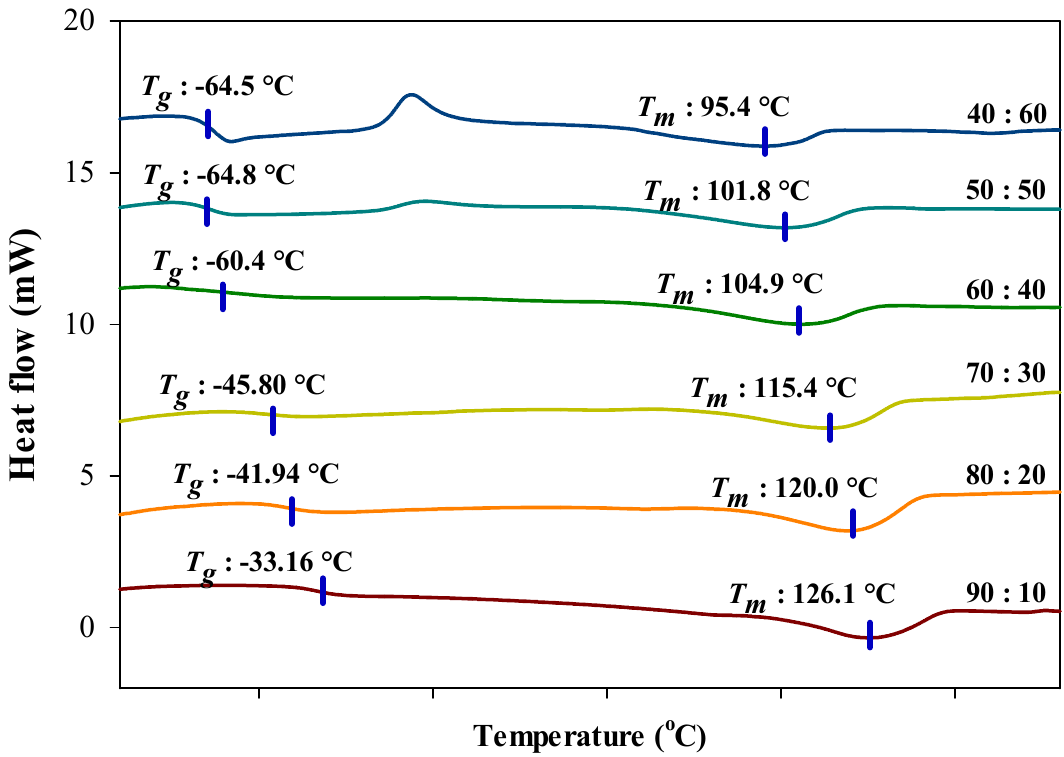
Figure 7. Differential scanning calorimetry (DSC) curves in the temperature range − 100 ◦ C to 180 ◦ C for different percentage ratios of PVDF-HFP to [BMIM][BF 4 ].